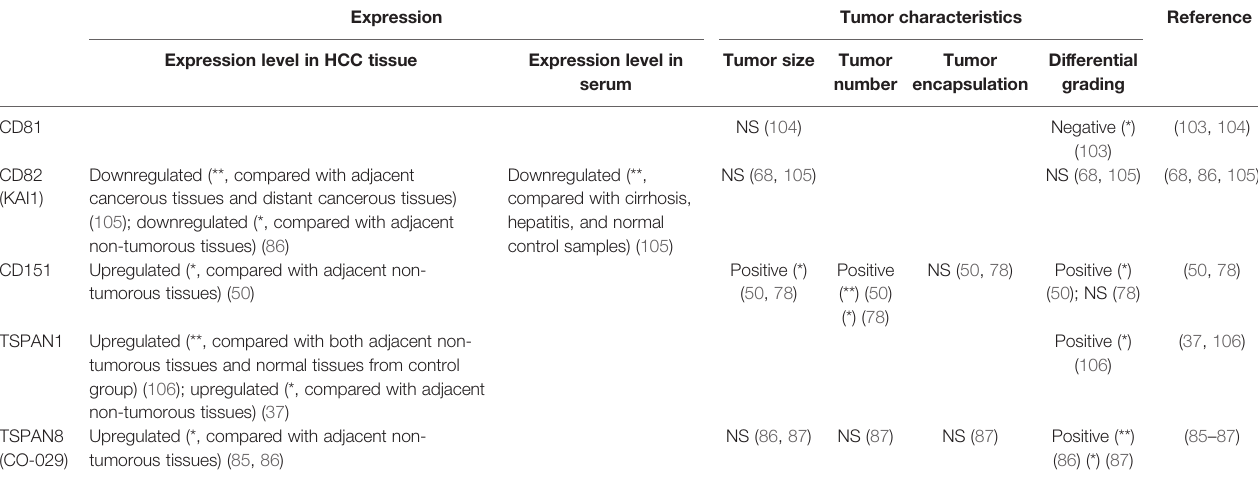
TABLE 2 | The expression level of tetraspanins and their relationship with tumor